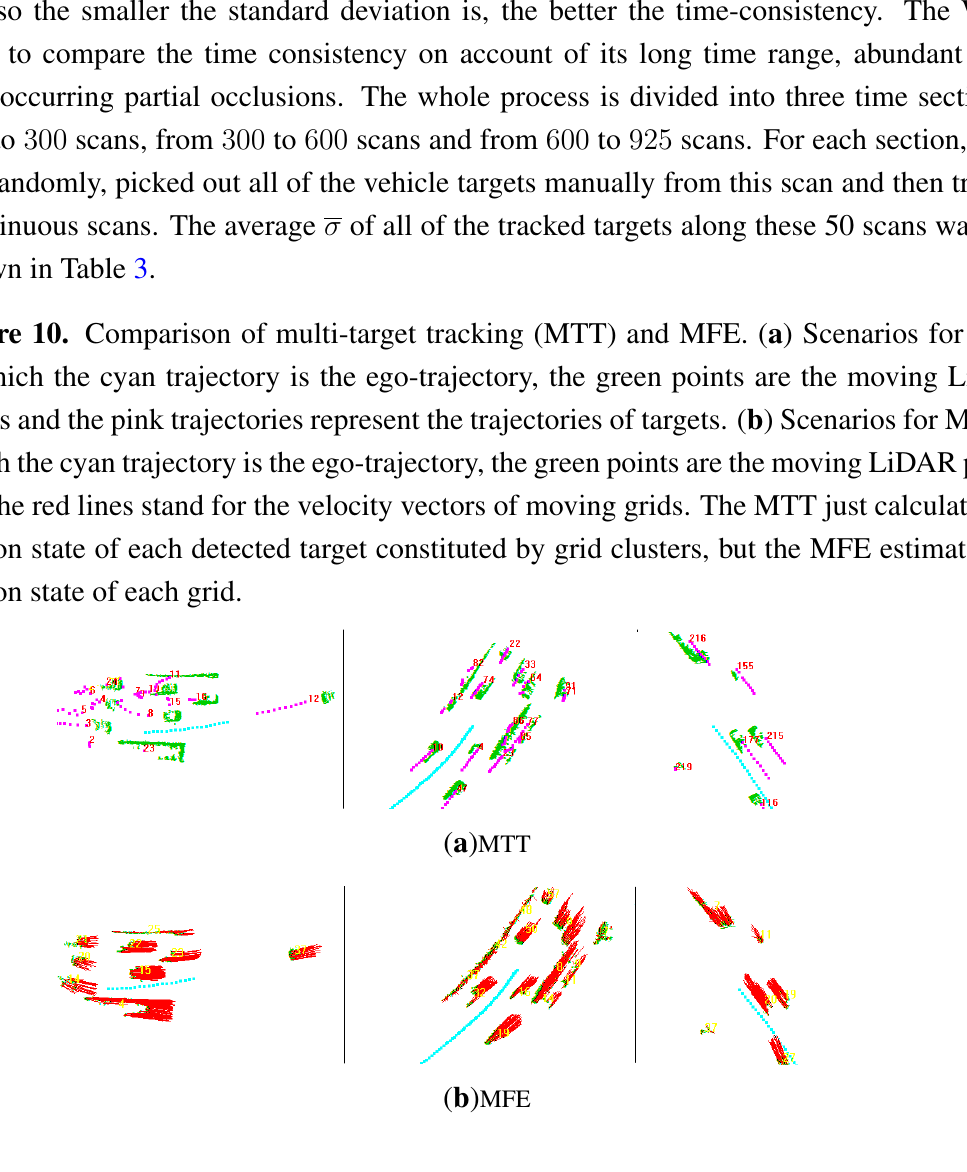
Table 3. The average standard deviation of the difference of the velocities between neighboring